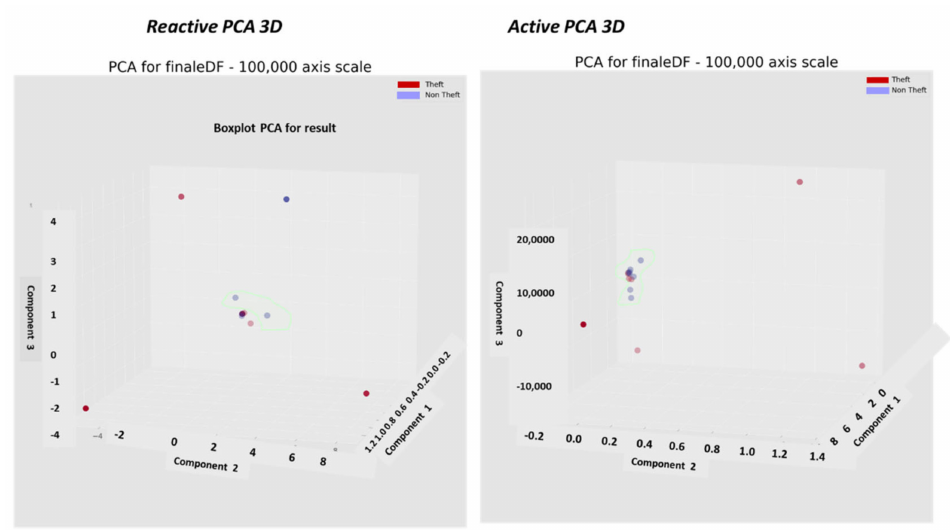
Figure 17. Active vs. reactive final-all features 3D PCA plot. Blue clusters are non-loss, while red clusters are